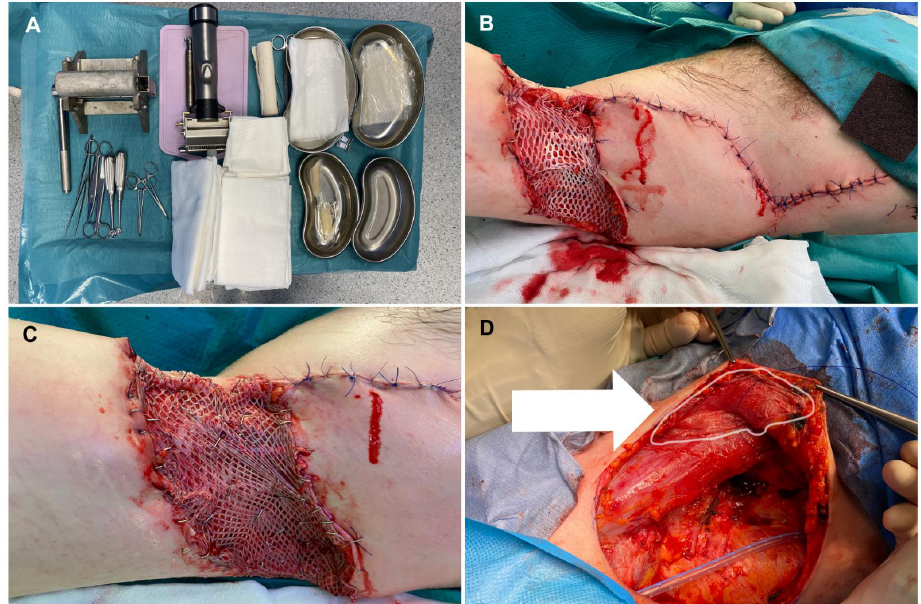
Figure 4. Multiple applications of ADM in Hidradenitis Suppurativa Surgery Reconstructions (own material). ( A ) Surgical equipment required for ADM and ADM-STSG co-graft surgery; photo shows